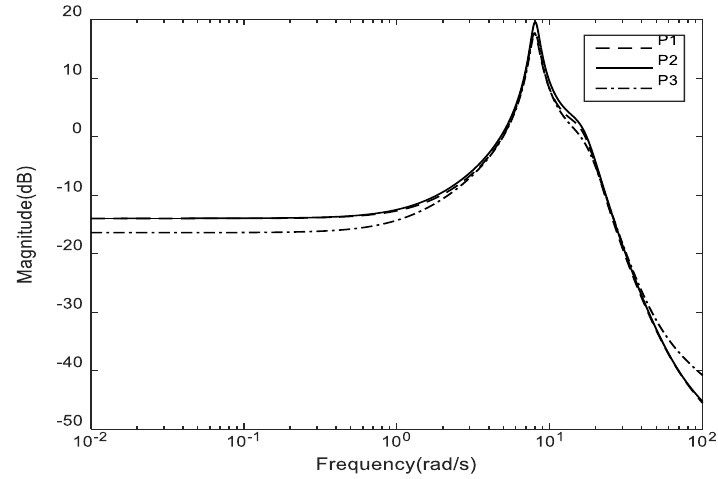
Figure 7. Magnitude Bode plot for the identified models P 1 , P 2 and P 3 .